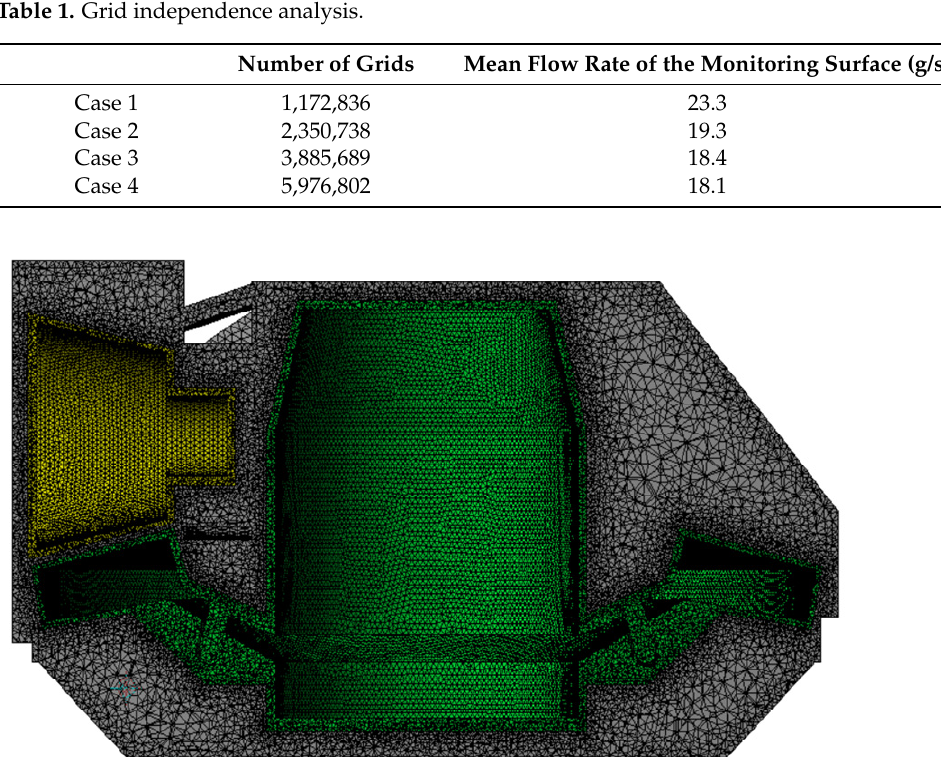
Figure 3. Central symmetry plane of the mesh model. Table 1. Grid independence